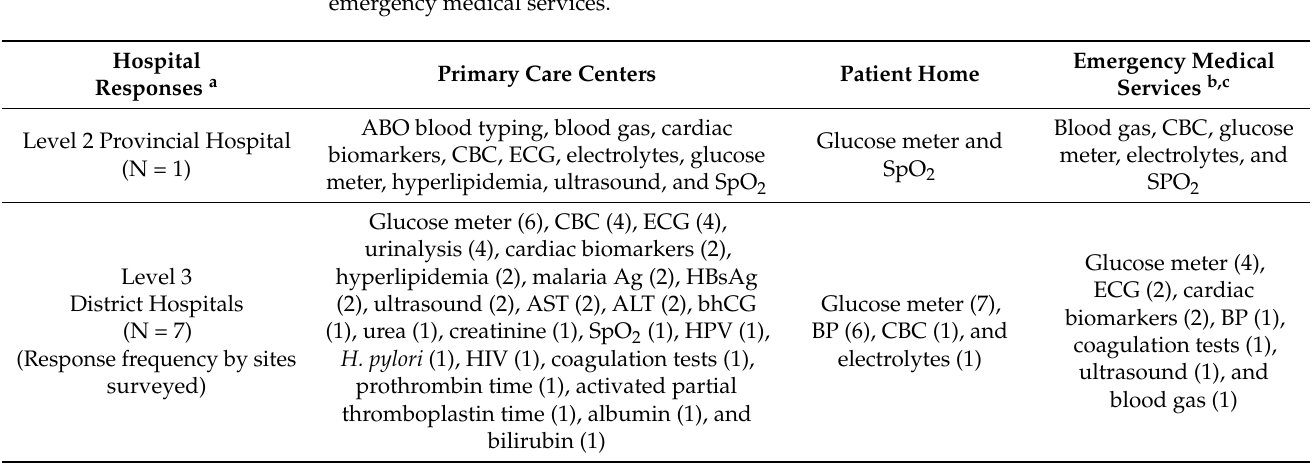
Table 6. Site-specific placement of POC resources in primary care centers, patient homes,